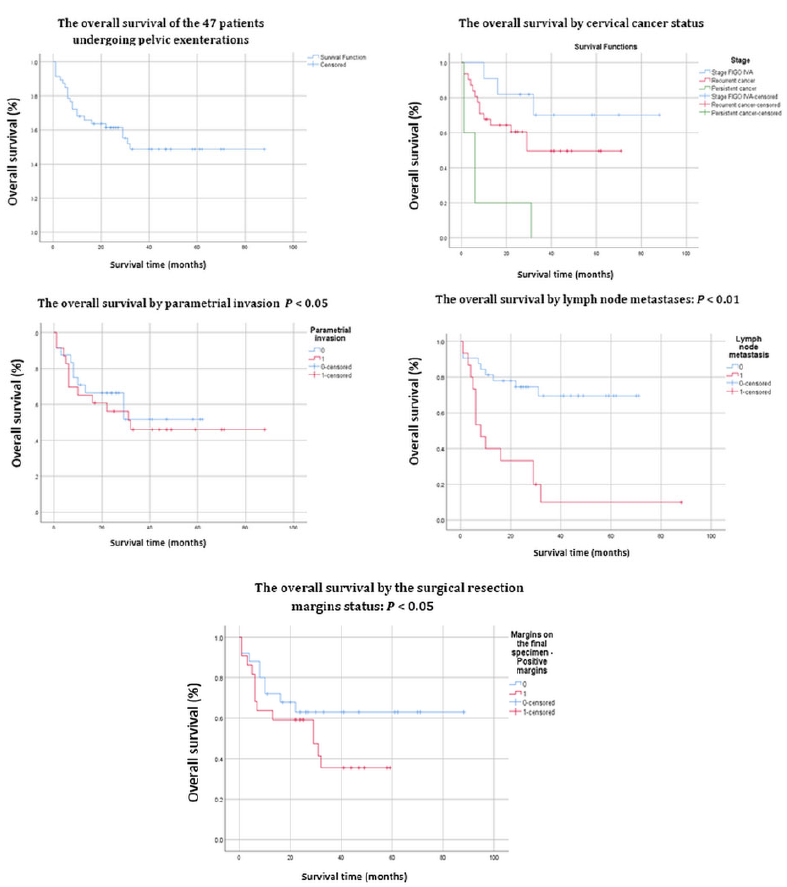
Figure 1. Kaplan–Meier survival curves of the 47 patients who had undergone pelvic